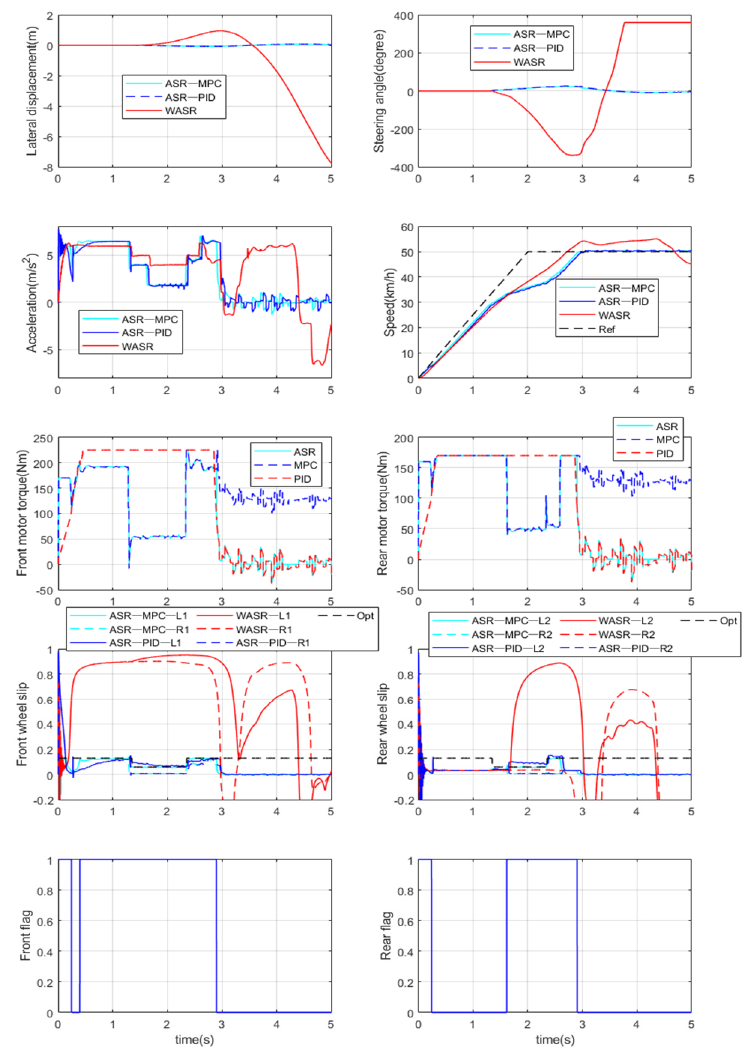
Figure 12. Vehicle starts on a split road. When entering the split road, the output torque of the motor is determined by the wheel with the smaller optimum slip rate. At 5–15 m, the optimal slip rate of the left wheels is 0.06. The vehicle has dual motors on the front and rear axles; hence, the torque of the left and right wheels on the same axis should be equal. When the left wheels keep up with the optimal slip rate, the output torque of the motor makes the right wheels’ actual slip rate less than 0.06, while the optimal slip rate of the right wheels is 0.13. If the actual slip rate is less than the optimal slip rate, then the generated longitudinal force increases with an increase in slip rate. In the simulation process, the longitudinal force generated by the right wheels is smaller than that of the left wheels. When the vehicle is traveling, differential steering is generated due to the difference in longitudinal force of the left and right wheels, and the vehicle is slightly deflected to the right. Accordingly, the PID controller is added to ensure that the vehicle drives on the split road within the 5–15 m